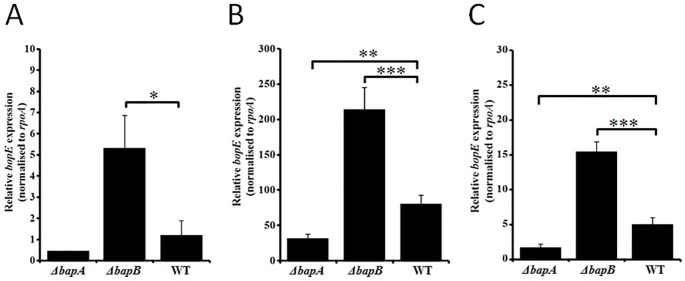
Transcription of bopE during the early (A) -, mid (B)—and late (C) -exponential growth phases.The level of bopE transcription in each sample was normalized to the expression of the housekeeping gene rpoA. The different strains analyzed were: ΔbapA, the ΔbapA strain; ΔbapB, the ΔbapB strain; WT, the wild-type strain. Data are expressed as mean ± SEM. Error bars represent the SEM from three technical replicates of biological duplicates. *P < 0.05, **P < 0.001, ***P < 0.0001.